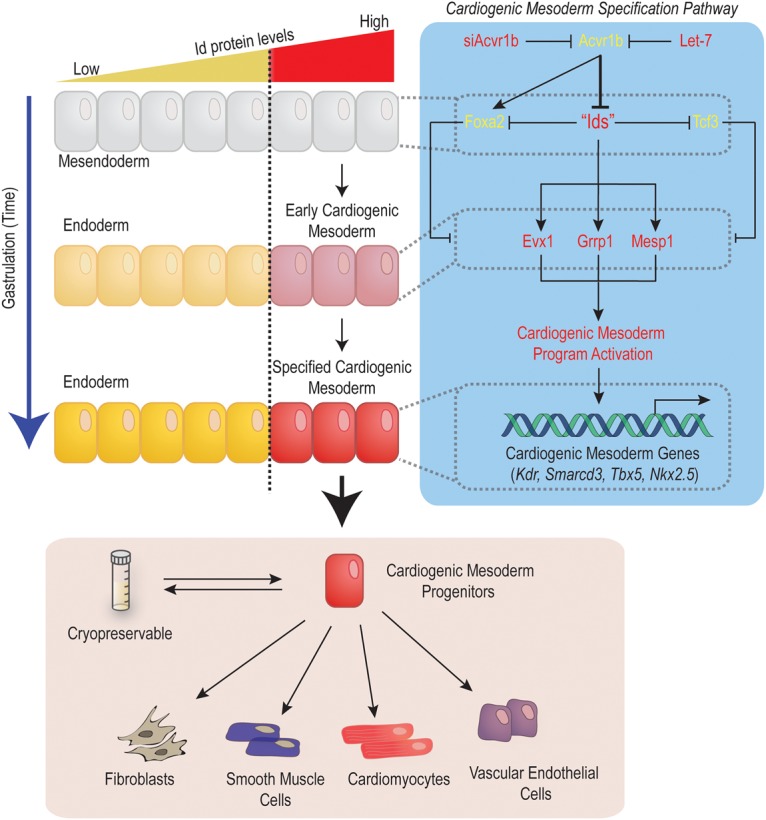
Id genes orchestrate cardiogenic mesoderm differentiation in vertebrates. Id genes control the activation of the cardiogenic mesoderm differentiation program in mesendoderm progenitors by inhibiting the activity of repressors (Tcf3 and Foxa2) while promoting the expression of activators of cardiogenic mesoderm differentiation (Evx1, Grrp1, and Mesp1). The Id-controlled network induces cardiogenic mesoderm (Mesp1 and Kdr) differentiation from pluripotent cells. Id1-induced CMPs generated from pluripotent stem cells are cryopreservable and spontaneously form contracting cardiomyocytes (∼70%) as well as vascular endothelial cells, smooth muscle, and fibroblasts.